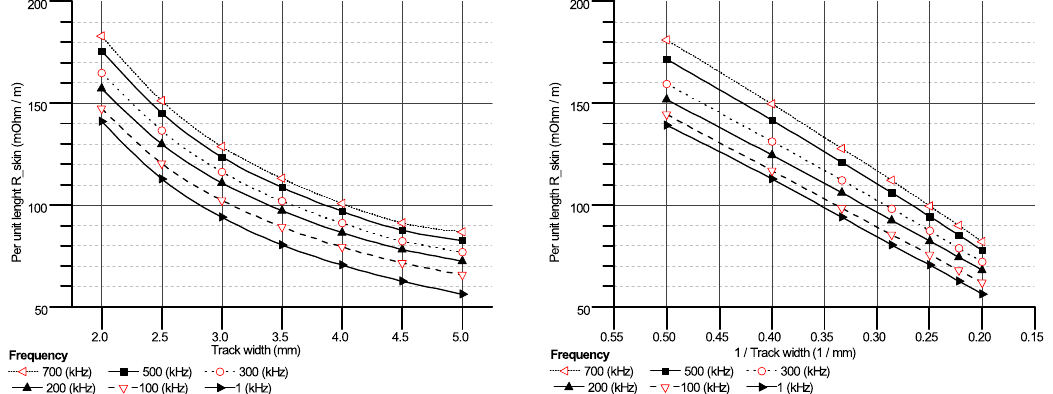
Figure 3. The per unit R skin of 2 Oz copper track with track width W ( left ) and inverse track width 1 ( right ) simulated by Ansys Maxwel.